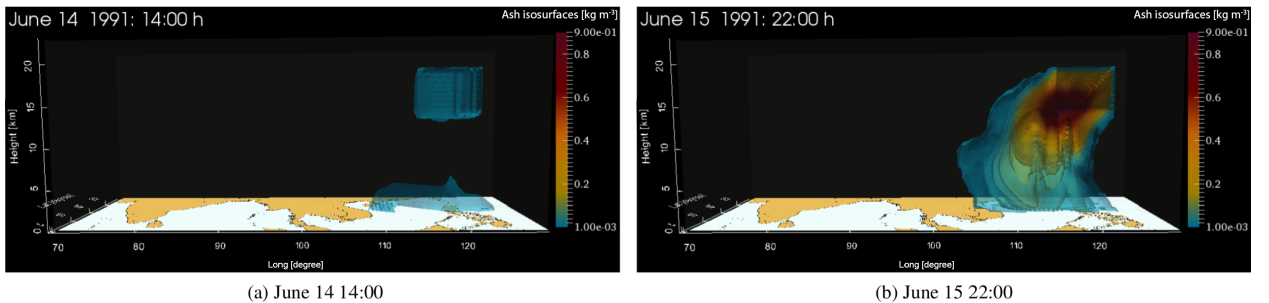
Figure 5. Ash concentration of the ash cloud on 14 June at 14:00 and on 15 June 22:00 for particles with a grain size of 4.5 φ . A cross section of isosurfaces of the ash concentration is displayed in kg m − 3 . The minimum displayed ash concentration is 0.001kgm − 3 .